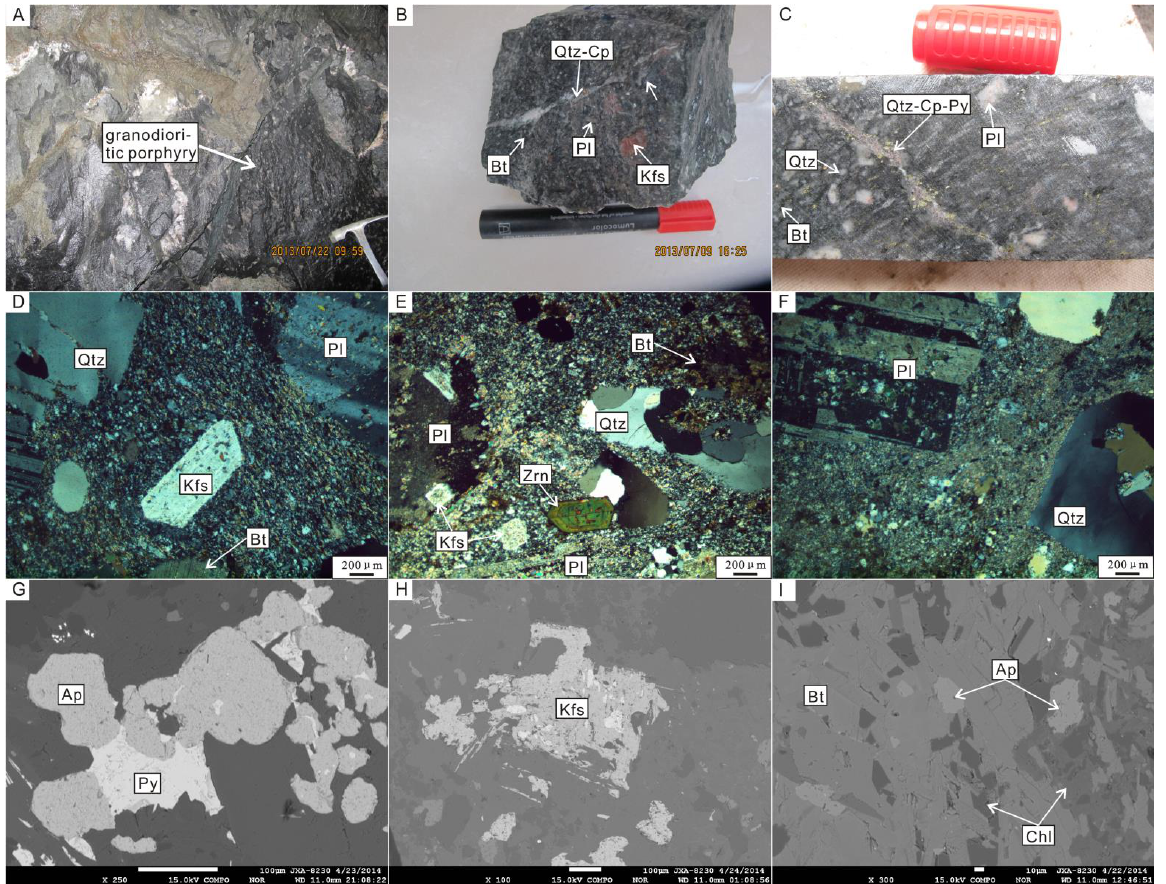
Figure 6. Representative photographs and photomicrographs of granodiorite porphyry from Tongkuangyu. ( A ) Biotite schist intruded by granodiorite porphyry (Sample 2596, No. 5147 tunnel of No. V orebody on 690-m level). ( B ) The granodiorite porphyry is cross-cut by quartz–